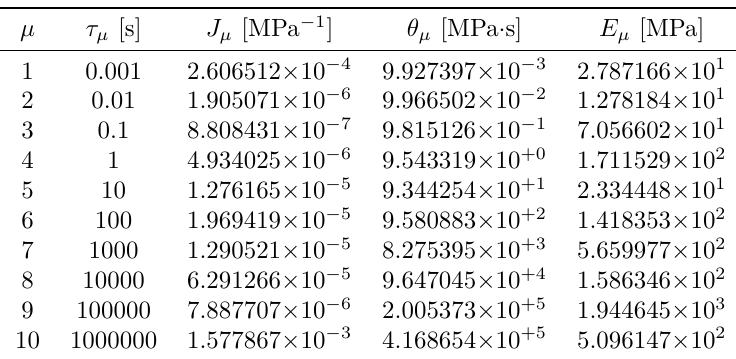
Table 1. Parameters of Maxwell chain model.